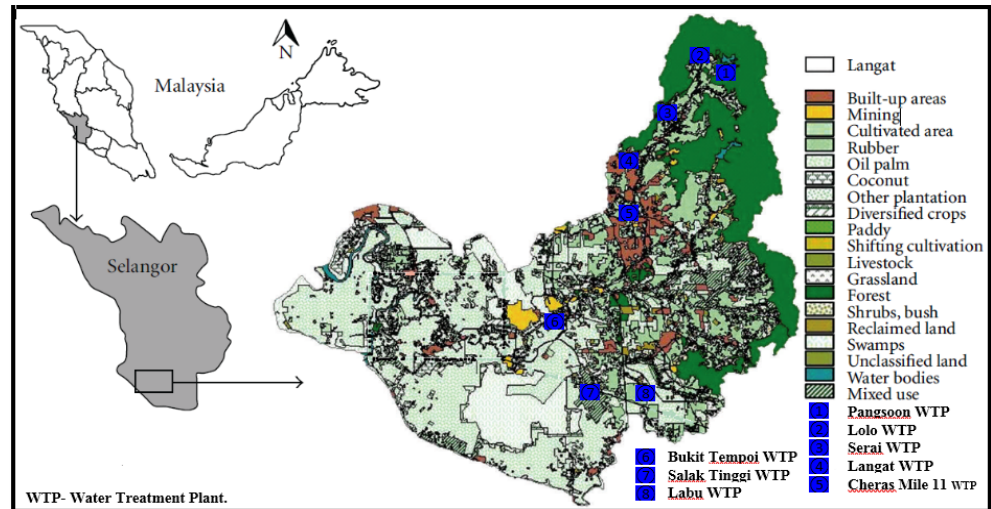
Figure 5. Land use map of Langat River Basin, Malaysia. Source: Modified from Lim et al. [33].